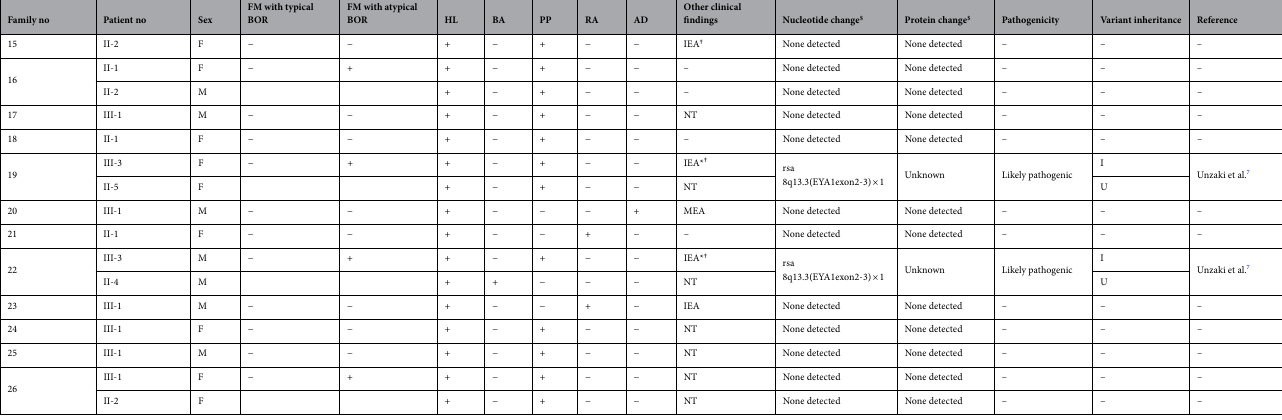
Table 2. Phenotypes and variants in patients with atypical BOR syndrome. F female, M male, FM family member, HL hearing loss, BA branchial anomalies, PP preauricular pits, RA renal anomaly, AD auricular deformity, EEA external ear anomaly, FA facial asymmetry, IEA inner ear anomaly, MEA middle ear anomaly, NT not tested, PT preauricular tag, I inherited, U unknown. *Includes enlarged vestibular aqueduct. ✝ Includes cochlear hypoplasia. $ Reference sequences for nucleotide numbering and protein numbering are NM_000503.5 and NP_000494.2,